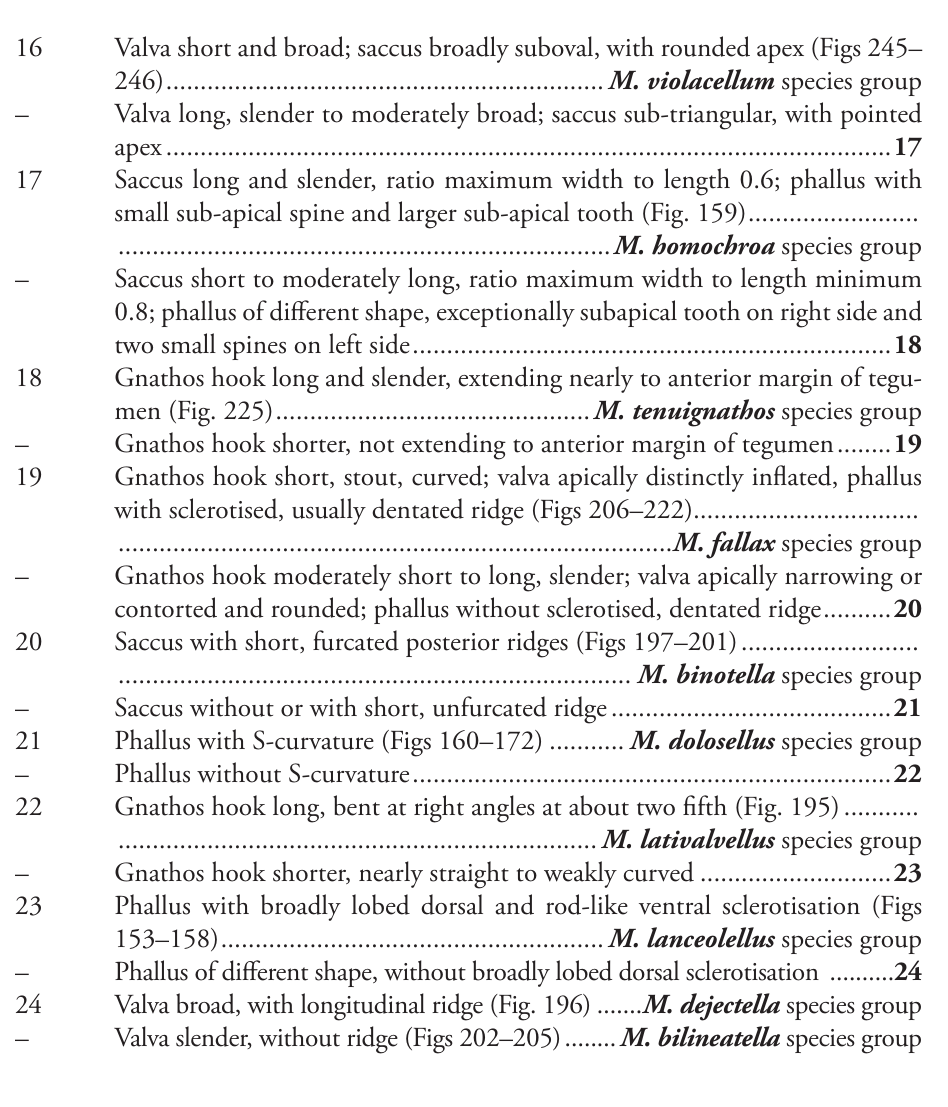
Taxonomic treatments of species Megacraspedus lanceolellus species group The M. lanceolellus species group includes two species: M. lanceolellus and M. bengtssoni sp. n. External morphology . Segment 2 of labial palpus with long scale brush; segment 3 shorter or about length of segment 2. Antennal scape without pecten. Wingspan (males) 12–15 mm. Forewing light greyish or yellowish with indistinctly lighter veins and 1–2 black dots. Known females slightly